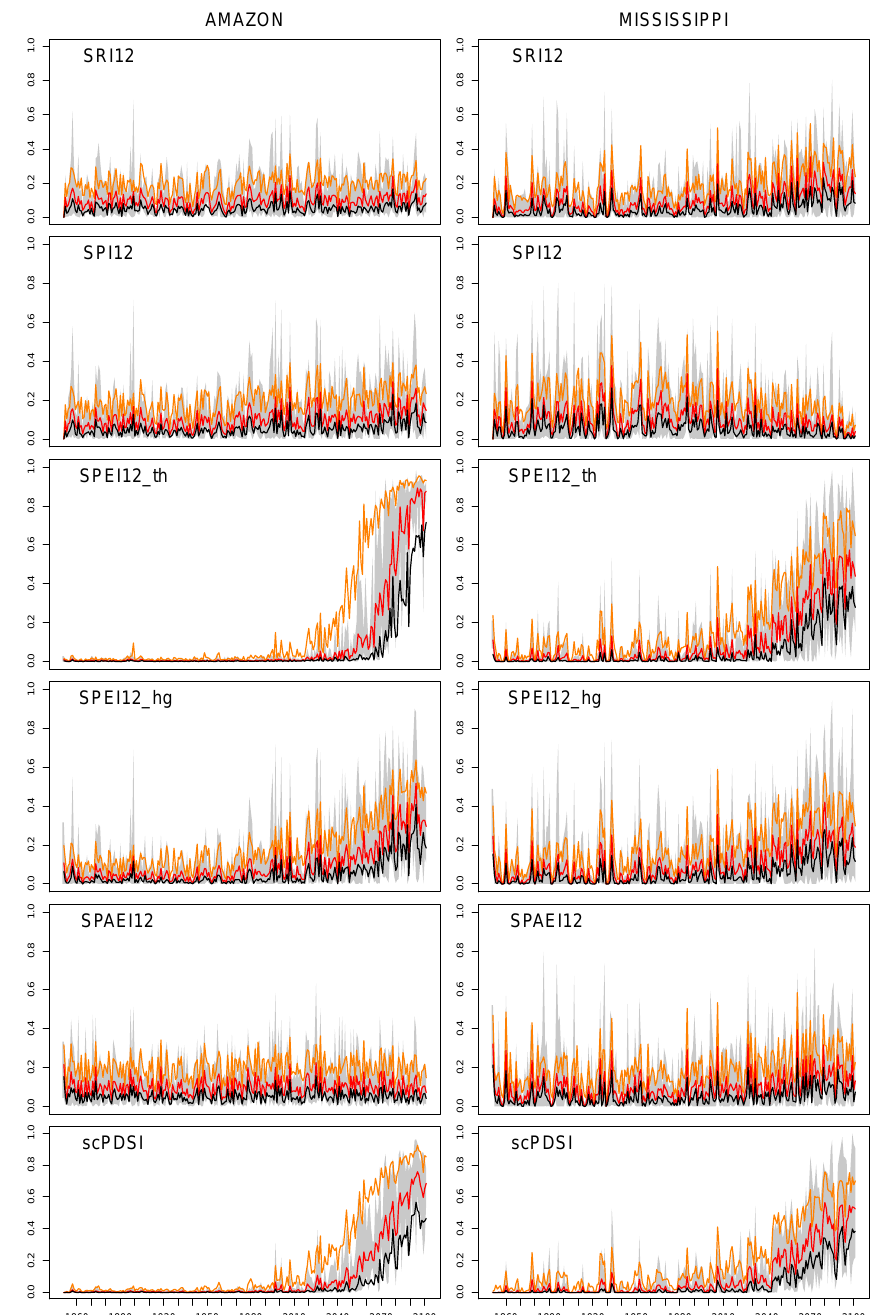
Fig. 3. Time series from 1850 to 2100 of the ensemble mean value of the areal fraction in drought condition in the Amazon and Mississippi basins. Moderate, severe and extreme droughts are defined locally as below the 20th (orange), the 10th (red) and the 5th (black) percentile. The envelop around the red line is defined by the minimum and maximum values among the five